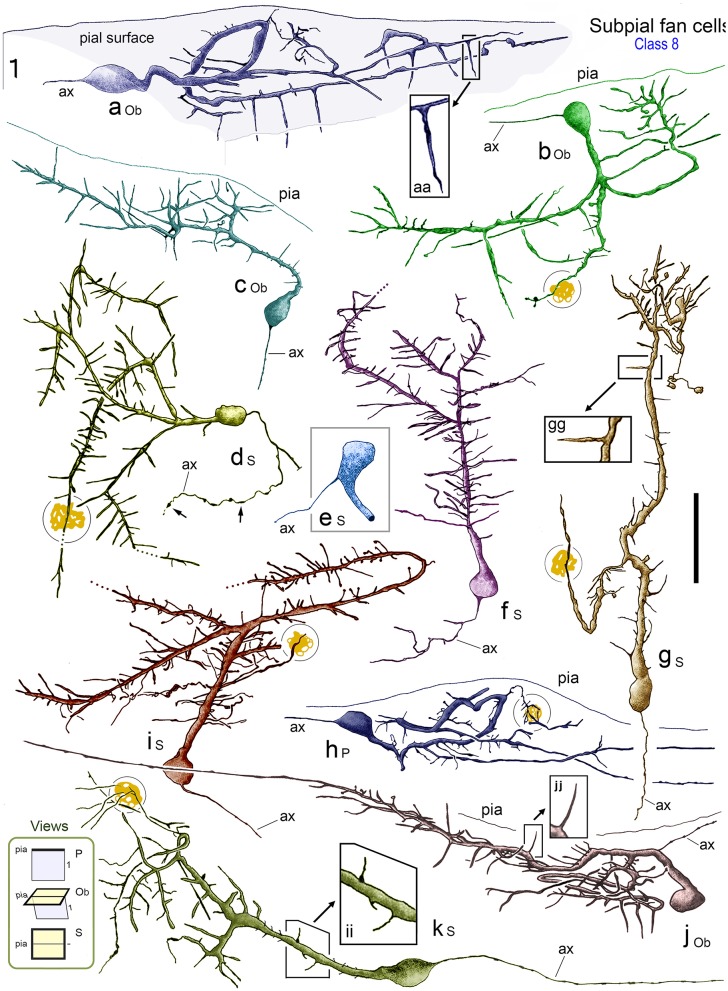
Reconstructions of class 8 SPF cells (a–k) in adult monkey PFC illustrating the broad range of dendritic morphologies. Boxed insets show enlarged examples of the thorn-like side branchlets that arise from the main processes of cells a, g, and j. All cells lay immediately below the pial surface and possessed a prominent main dendrite that coursed tangentially within upper layer 1. [Lower left inset codes viewing planes with respect to the plane of the pial surface as: P, perpendicular; Ob, oblique; S, surface]. All cells had a single fine axon-like processes (ax) emerging either from the opposite somatic pole (cells a, c, d, f, g, h, i), from the side of the soma (cell b), base of the main dendrite (cell e) or proximally along the primary process (cell j). Axonal varicosities are indicated (small arrows). Note the long thorns of cells a, g and j and the terminal interwoven dendritic processes of cell g (c.f. cells in Figure 8). Some cells had lipofuscin-rich regions associated with their dendrites (shown encircled). Areal locations of cells: a, area 46d; b, area 25; c, area 32; d, area 24a; e, area 46d; f, area 32; g, area 24c; h, area 32; i, area 46v; j, area 9; k, area 24c. Scale bar: 50 μm.